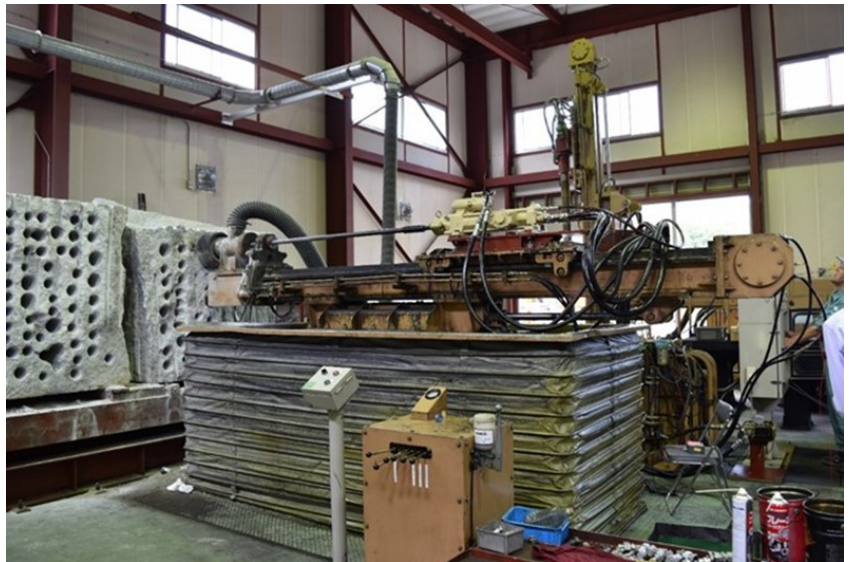
Figure 3. Experimental setup. 18 m 3 of granite rock was horizontally drilled using a stationary rock drifter with accelerometers mounted on the guide cell of the rock drifter. Acceleration data was transmitted from the accelerometers to the data logger and then stored in the PC as CSV data. Table 1. Experimental conditions. Table 2. Parameters of the experiment.